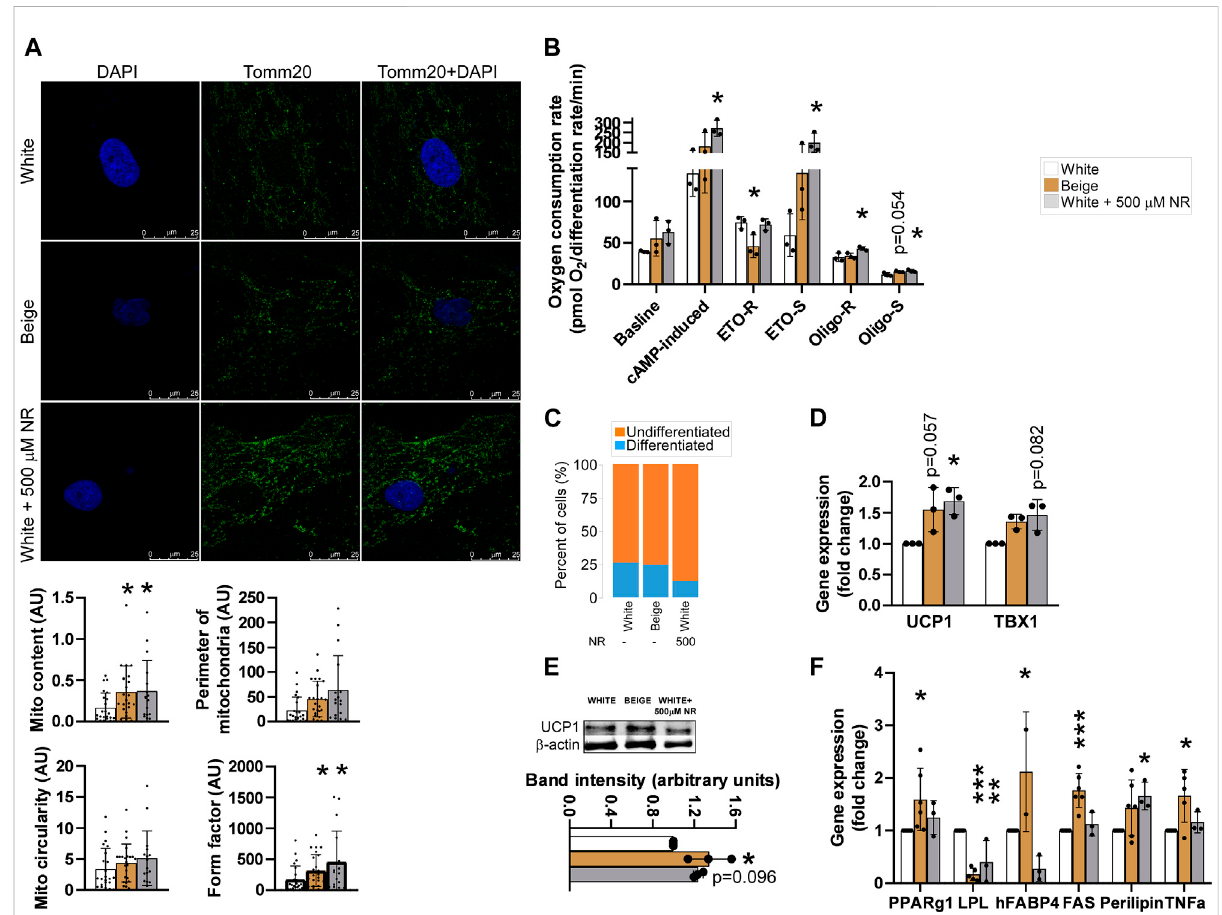
stained with TOMM20 antibody, then mitochondrial quantity and morphology were evaluated (B) Human adipose tissue-derived mesenchymal stem cells were seeded into Seahorse assay plates and assayed after differentiation. Mitochondrial oxygen consumption was assessed as described in Materials and Methods. (C) Adipocyte differentiation rate was determined as described in Materials and Methods (D) The expression levels of the indicated genes were measured by RT-qPCR in differentiated human adipose tissue-derived mesenchymal stem cells. (E) UCP1 protein expression was measured by Western blot in differentiated human adipose tissue-derived mesenchymal stem cells (F) The expression levels of the indicated genes were measured by RT-qPCR in differentiated human adipose tissue-derived mesenchymal stem cells. Normality was checked. Statistical signi fi cance was assessed by One-way ANOVA test followed by a post-hoc test versus white adipocytes. *, **, *** indicate signi fi cant differences between groups at p < 0.05, p < 0.01 or p < 0.001, respectively. Data are represented as means ± SD. Data are expressed as fold change normalized to white adipocytes. Abbreviations: ETO-S, etomoxir sensitive; ETO-R, etomoxir-resistant; hADMSC, human adipose tissue-derived mesenchymal stem cell; NR, nicotinamide-riboside; PAR, poly